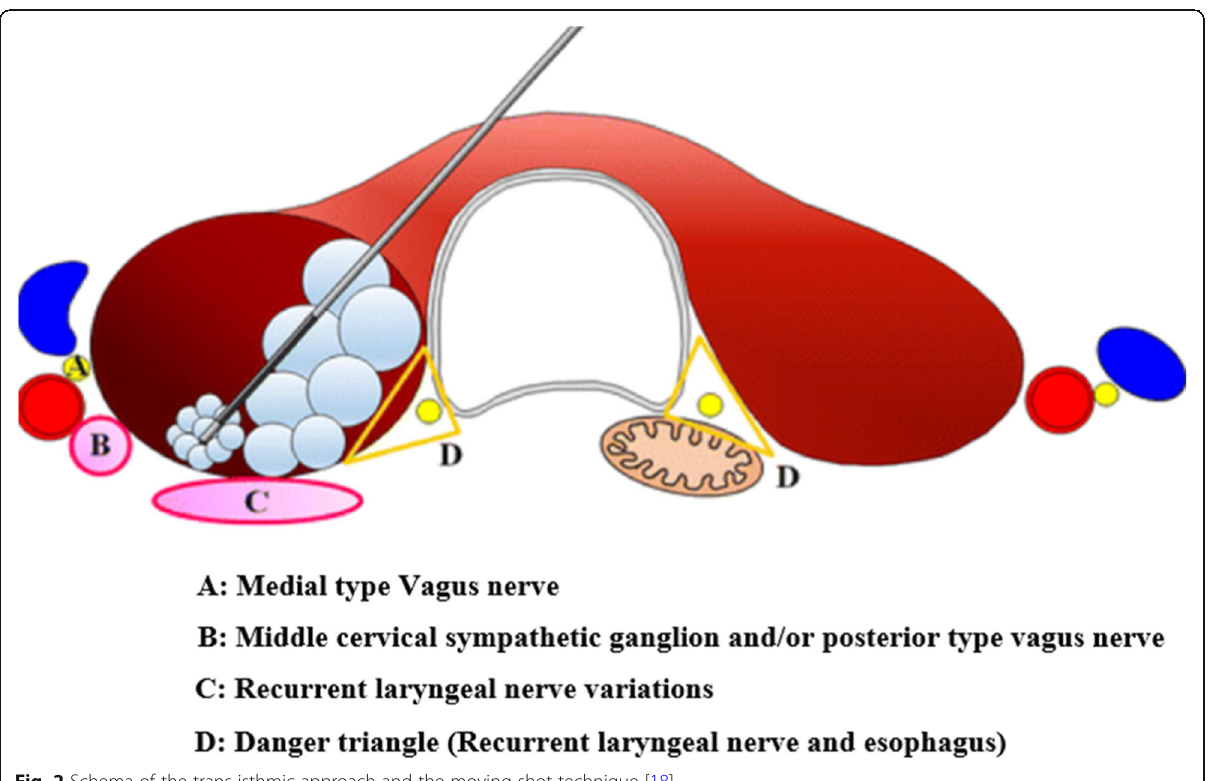
Fig. 2 Schema of the trans-isthmic approach and the moving shot technique